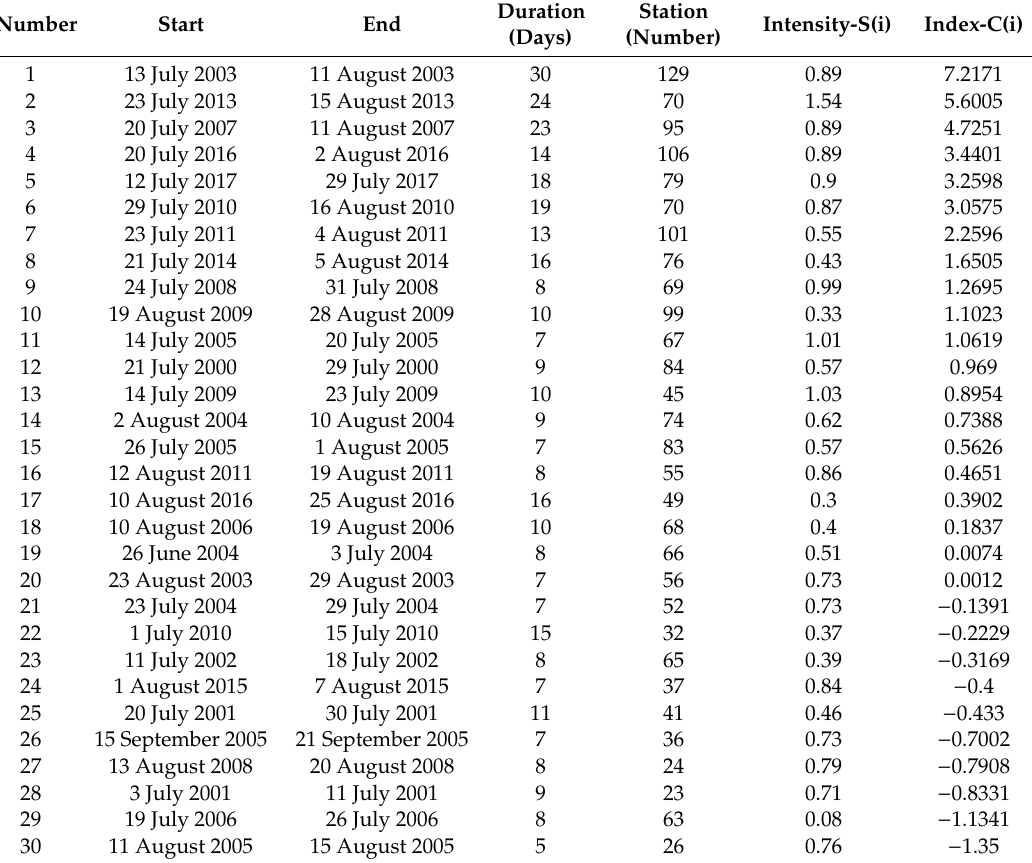
Figure A1. The study region and distribution of the stations. Table A1. The heat-wave events in southern China from 2000 to 2017.